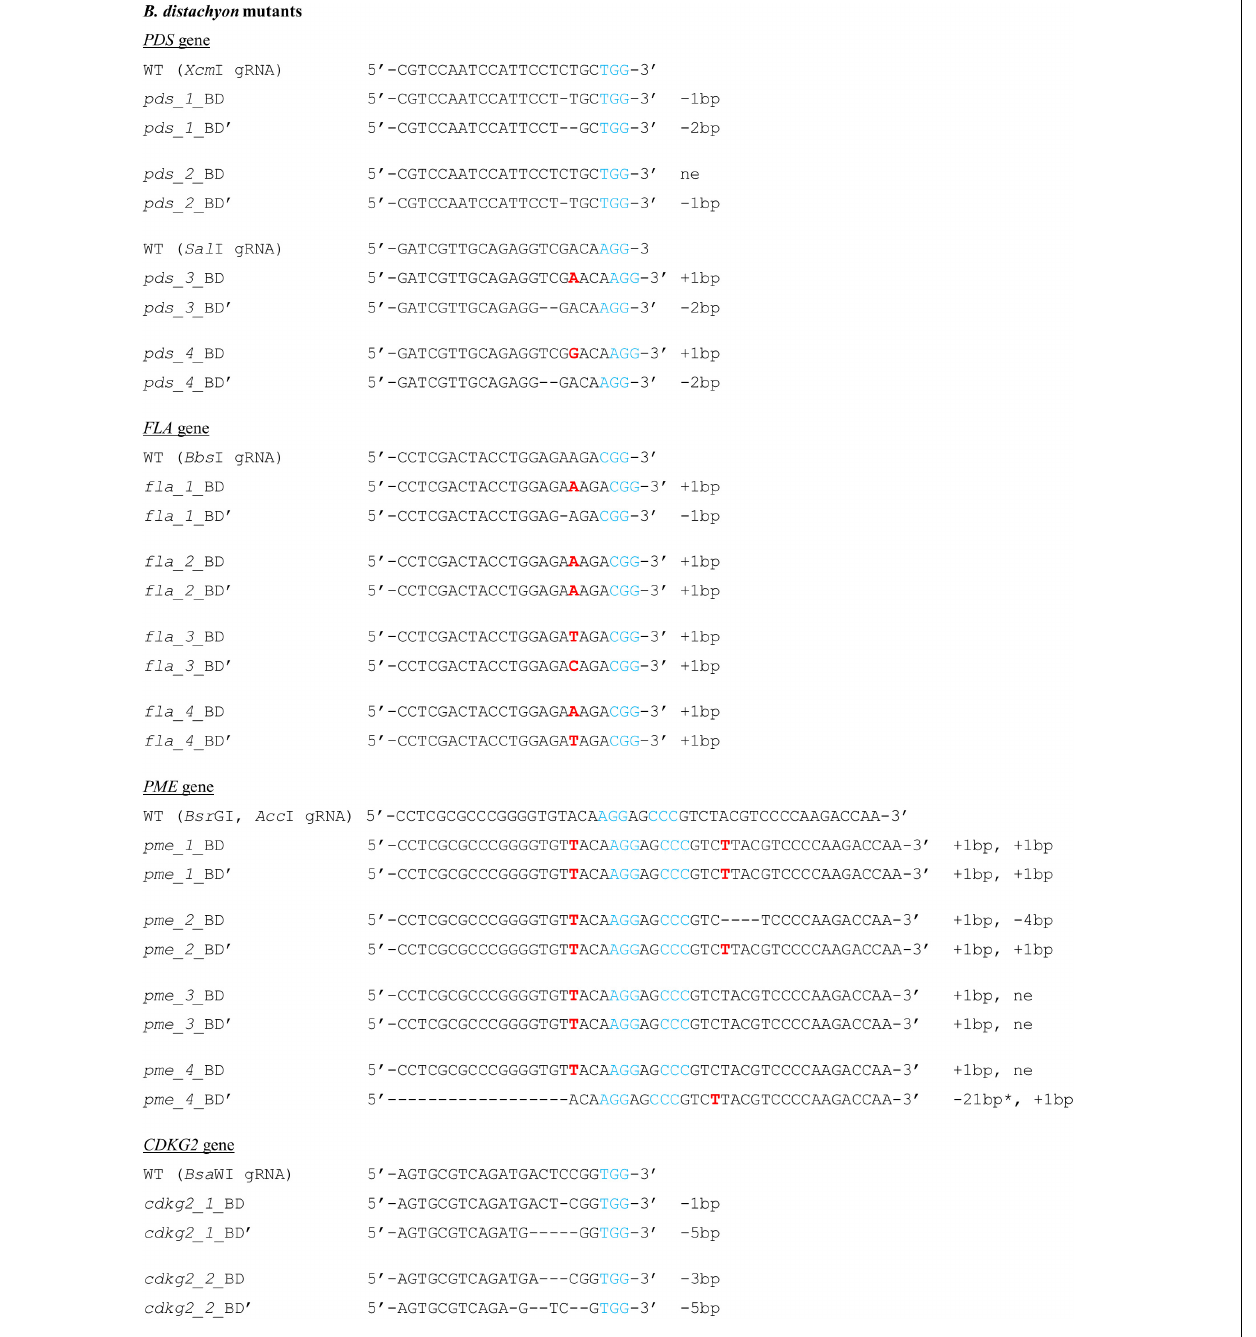
FIGURE 7 | Nature of mutations obtained using CRISPR/Cas9 targeted mutagenesis in T0 plants of B. distachyon . Deletions are denoted as hyphens (-) and insertions as bold red letters. The PAM sequence is shown in blue. Individual plants are marked with numbers. The sequences of both alleles are presented and marked as BD, BD’. * - the mutation goes beyond the gRNA sequence. bp – base pairs, ne – not edited